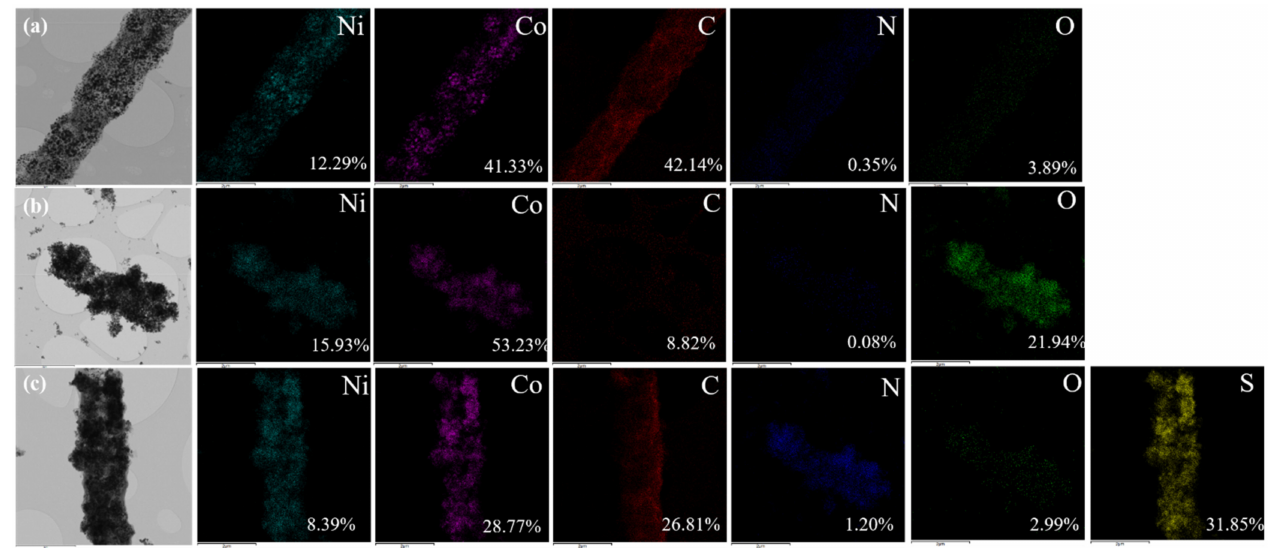
Figure 6. The TEM images and elemental mappings of multi-doped porous carbon nanofibers derived from Ni 1 Co 4 -ZIFs/PAN nanofibers by ( a ) carbonization, ( b ) oxidation, and ( c ) sulfurization in different atmospheres (Ar, Air, and H 2 S) at 800 ◦